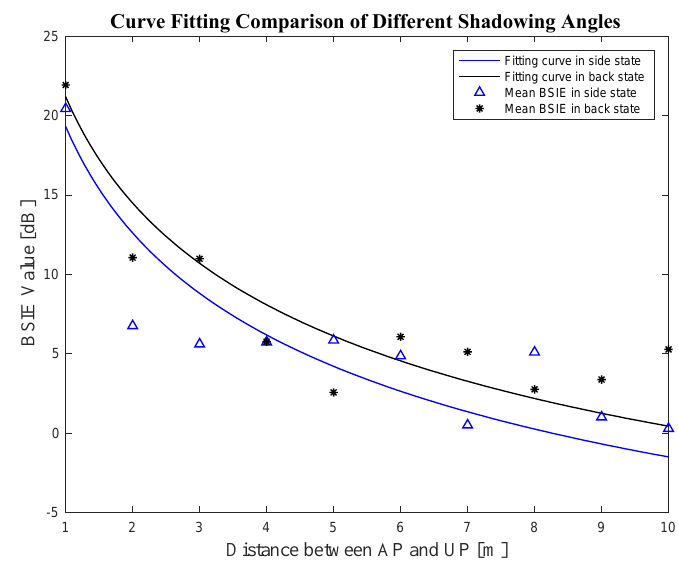
Figure 13. The curve fitting results comparison of different shadowing angles. Table 2. The parameters for the BSIE compensation model from curve fitting.